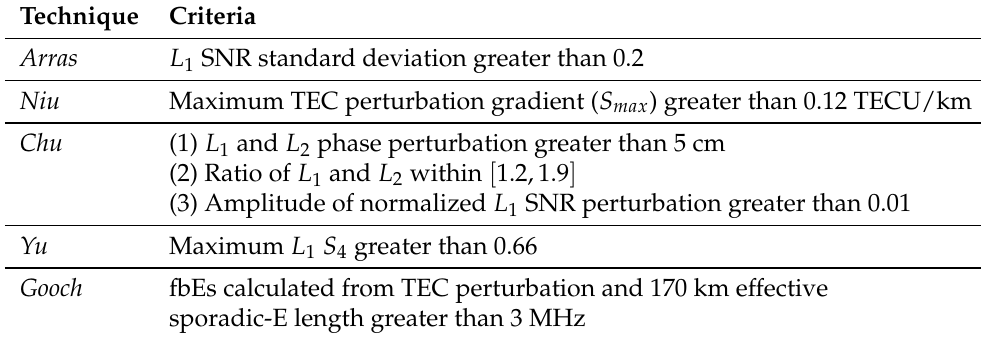
Table 1. A summary of the binary sporadic-E criteria for each of the five GPS-RO techniques.